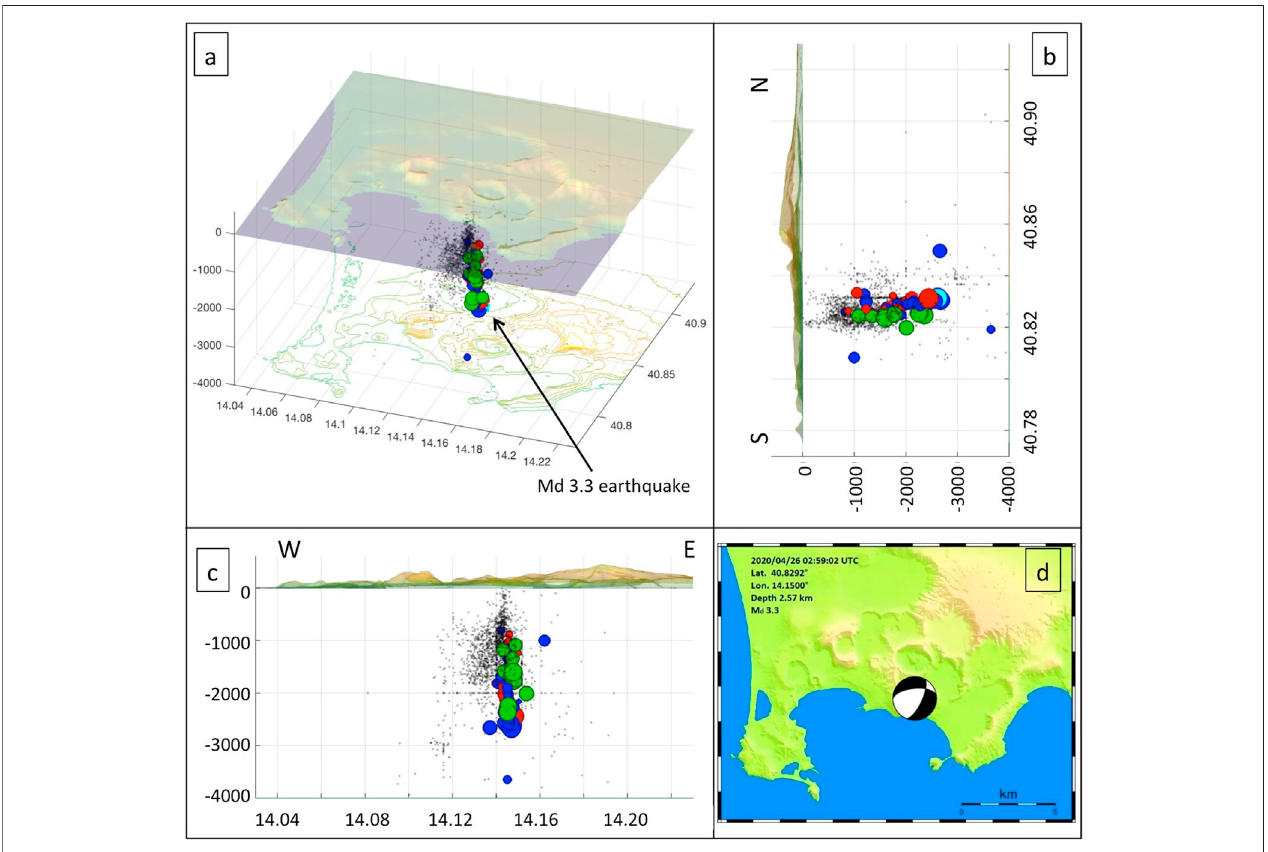
FIGURE 7 | Locations (A and B quality) of the earthquakes recorded in Campi Flegrei between January 2000 and November 2020. The hypocenters are indicated withablackdot(70%transparency).ThegreencirclesmarktheearthquakesoftheOctober7,2015swarm.TheredcircleshighlighttheearthquakesoftheDecember6, 2019 swarm. The blue circles indicate the earthquake locations of theApril26, 2020swarm (included in supplementary Datasheet S1 ). Only for events that belong to these three swarms the diameter of the circle is proportional to the magnitude. The location of the April 26, 2020 Md 3.3 earthquake is shown in cyan (lat: 40.831319N; lon: 14.147029E; depth: 2,618 m b.s.l.).